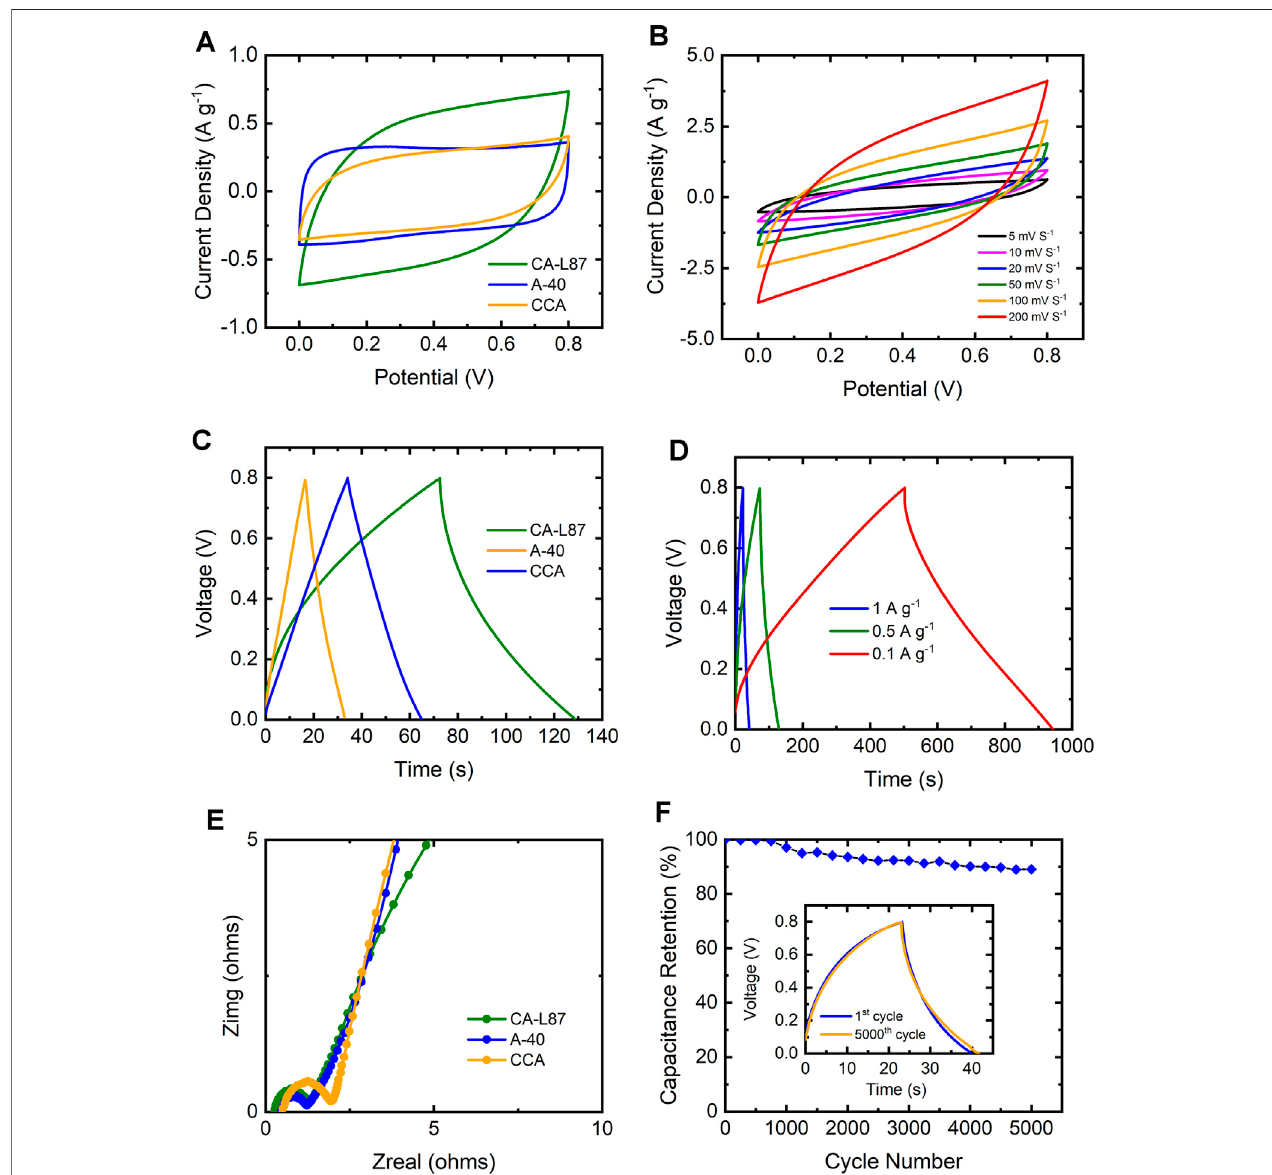
FIGURE 6 | Electrochemical properties of lignin carbon aerogel CA-L87 in comparison to a commercial activated carbon (A40) and a RF-based carbon aerogel (CCA); (A) CVcurvesatthe20 mVs − 1 scanrate, (B) CV curves ofCA-L87withdifferentscanrates, (C) GCDcurves ofthesamplesat0.5 Ag − 1 currentdensity, (D) GCD curves ofthe CA-L87 at different current densities, (E) Nyquist plots, (F) capacity retention performance of CA-L87 electrode after 5,000 cycles (inset: GCD curve at the 5000th cycle).